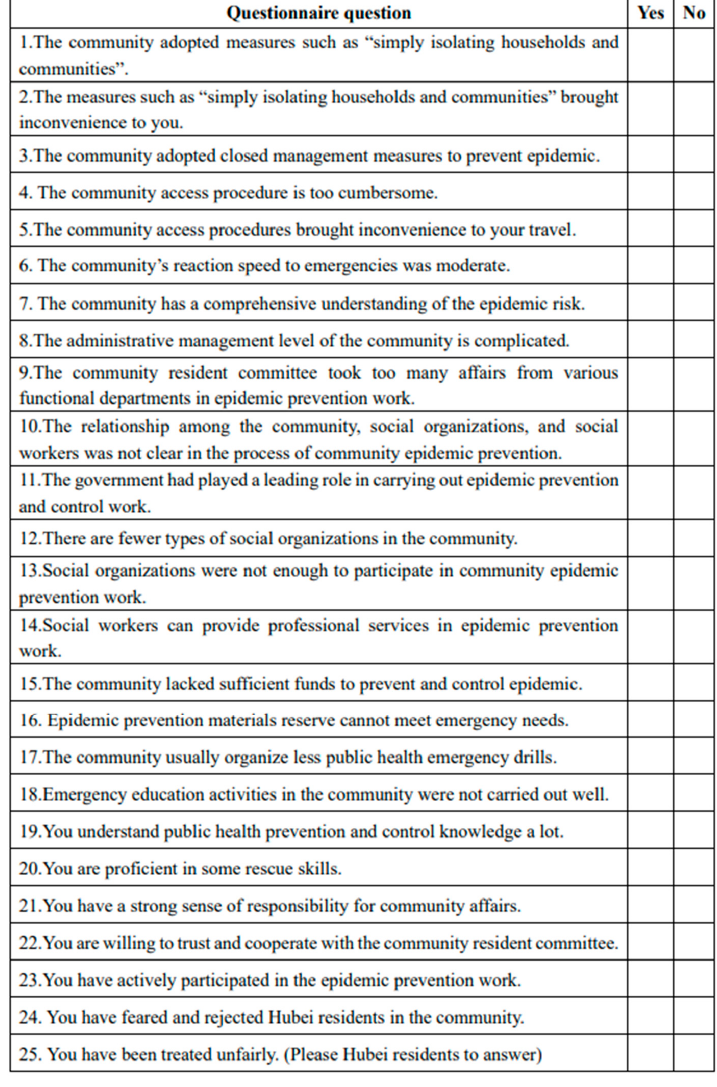
Figure 4. The questionnaire questions involved in this paper.